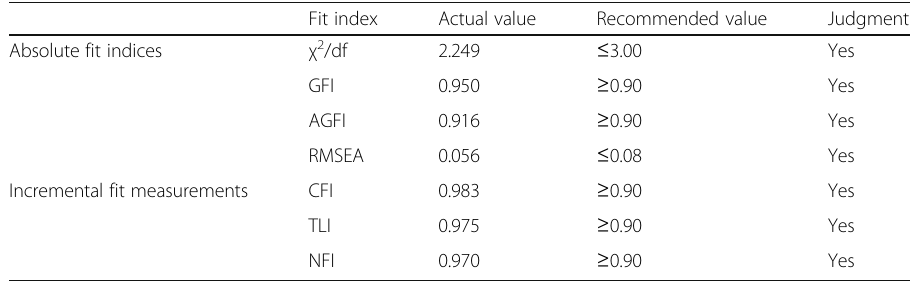
Table 2 Goodness-of-fit